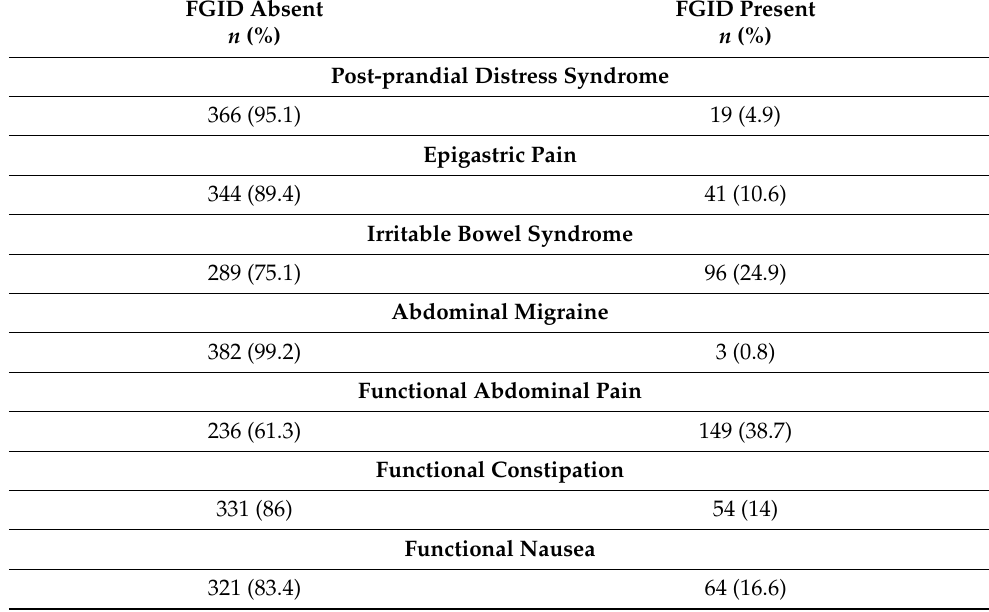
Table 3. Prevalence Data for Functional Gastrointestinal Symptoms in Children Enrolled in the Study ( n =